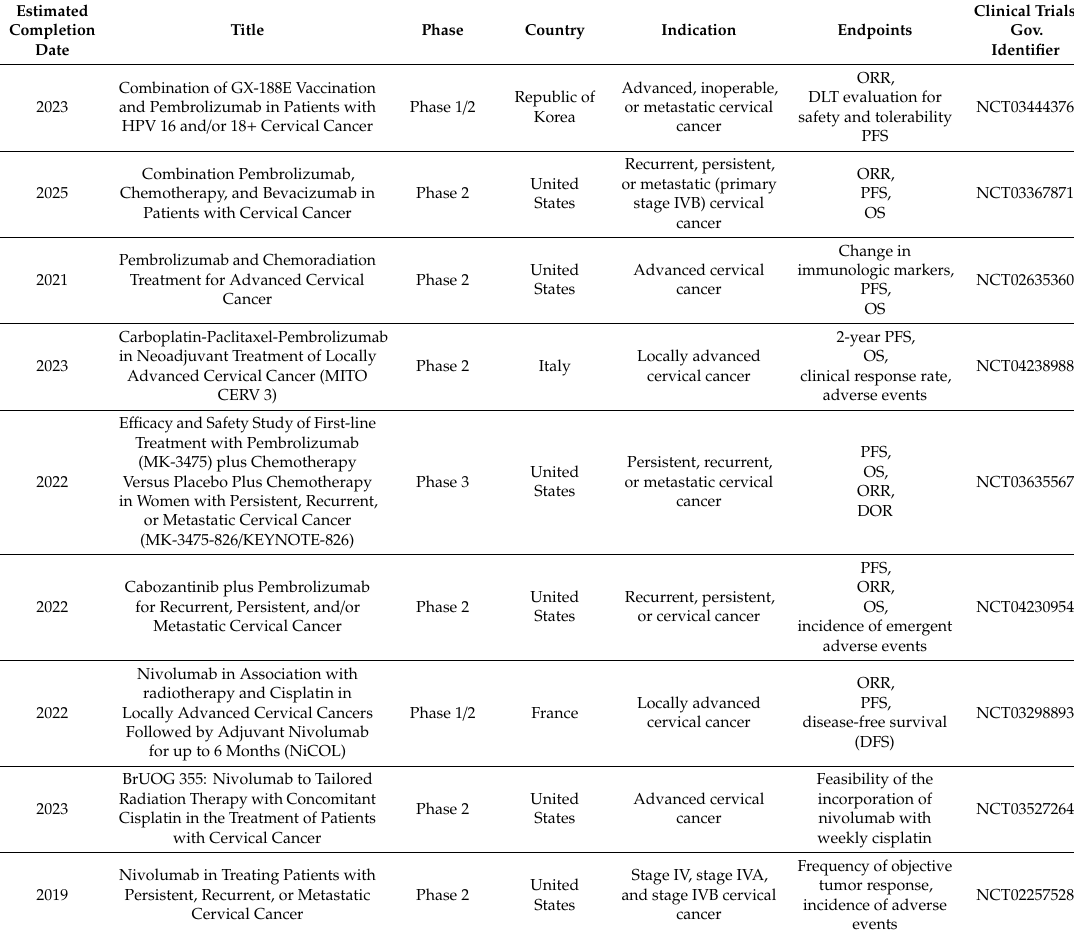
Table 1. Selected ongoing (up to February 2020) trials of nivolumab and pembrolizumab in cervical